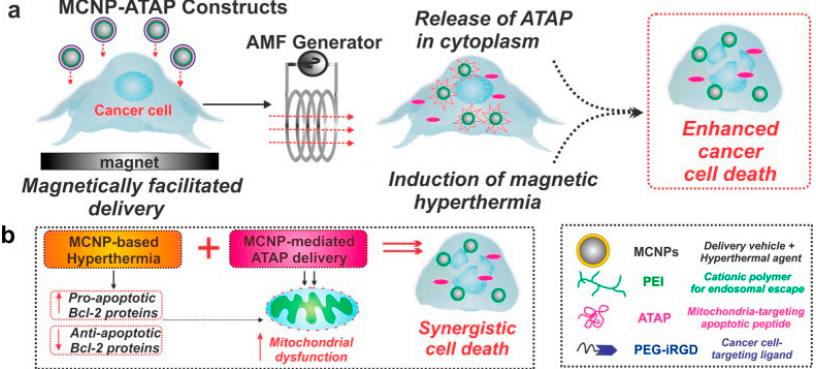
Figure 2. Schematic diagram depicting magnetically targeted delivery of MCNP-ATP to brain and breast cancer cells. ( a ) The release of ATAP from the MCNPs together with the induction of magnetic hyperthermia in the presence of an alternating magnetic field (AMF) results in synergistic cell death; ( b ) MCNP-based hyperthermia can inactivate anti-apoptotic bcl-2 proteins with a concomitant increase in the pro-apoptotic bcl-2 proteins, which results in cancer cell apoptosis, while MCNP-ATP can permeabilize the outer mitochondrial membrane and induce mitochondrial dysfunction. MCNP, magnetic core-shell nanoparticles; PEI, polyethylenimine; ATAP, amphipathic tail-anchoring peptide; PEG, polyethylene glycol; iRGD, internalizing RGD. Reprinted with permission from [65].